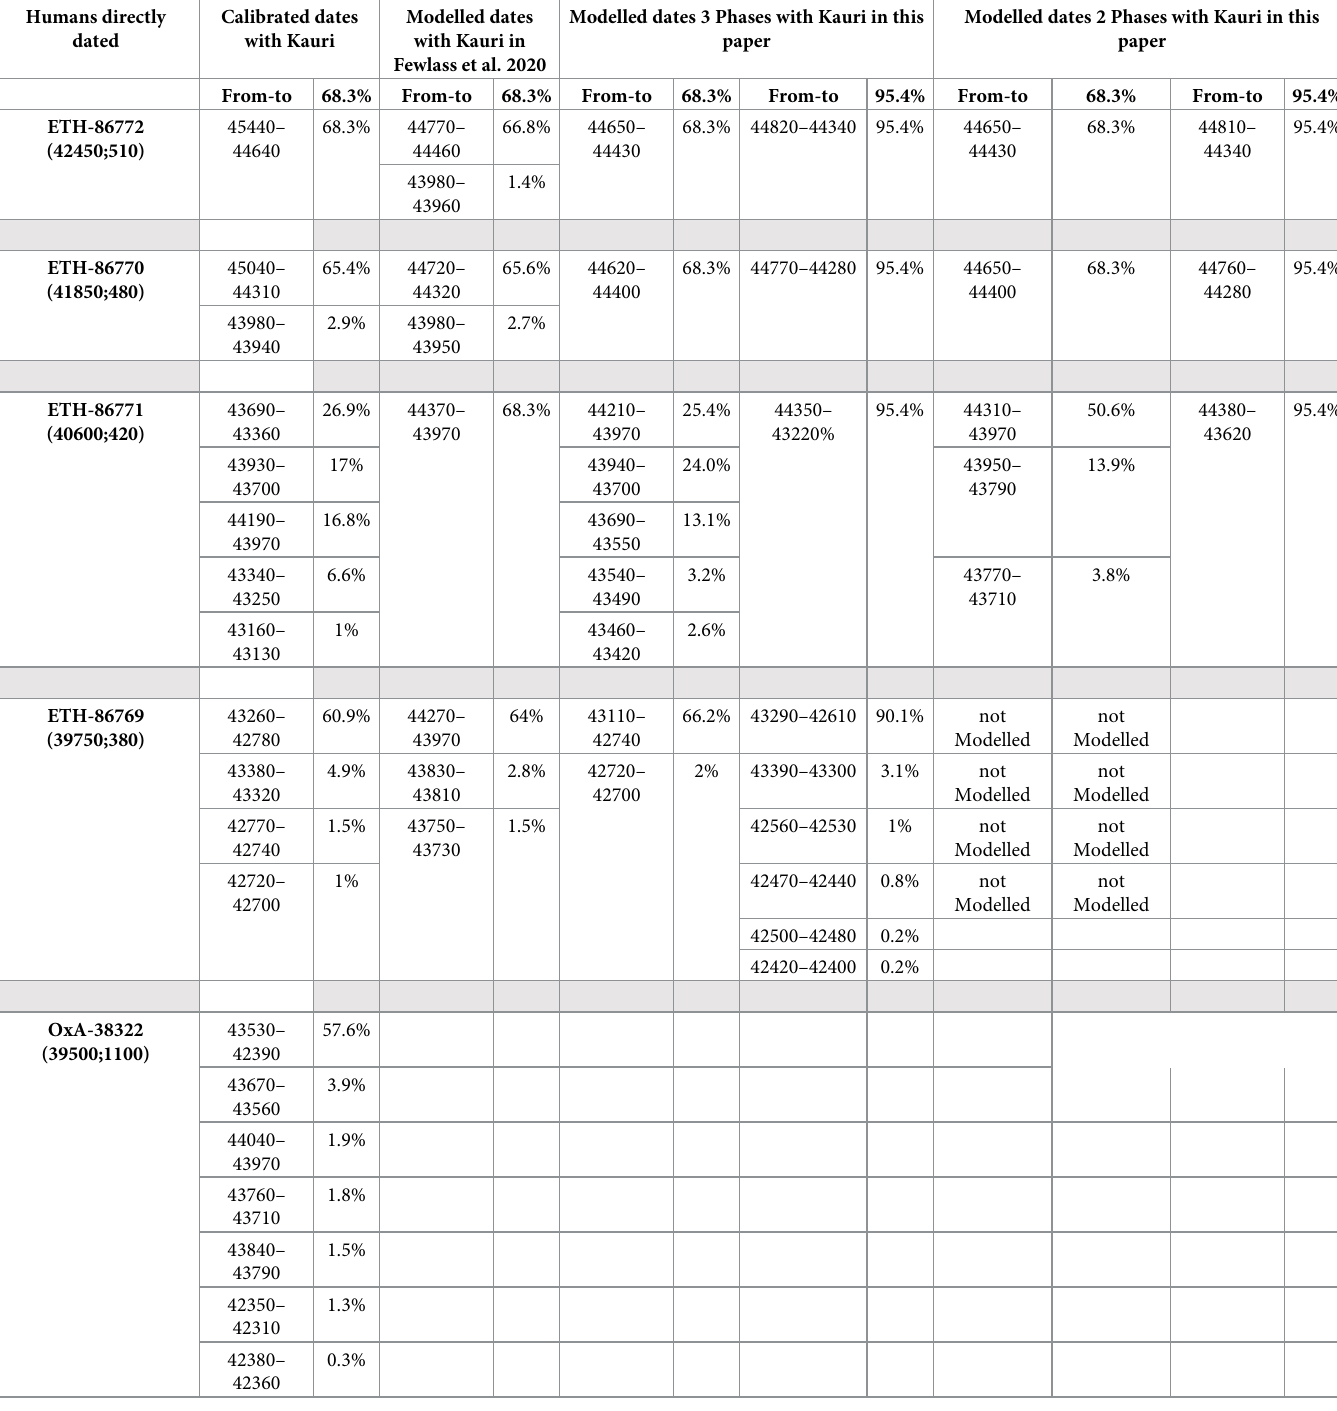
Table 3. Radiocarbon ages of the direct dates of 4 Homo sapiens from Bacho Kiro and 1 Neanderthal from Fond-de For ê t. The respective calibrated results using IntCa20+Kauri in OxCal4.4 [58], the ranges obtained in the model of [35] calibrated using IntCal 20+Kauri section. The ranges obtained in the 3 phases model, calibrated using IntCal 20+Kauri section, and the ranges obtained in the 2 phases model, calibrated using IntCal 20+Kauri